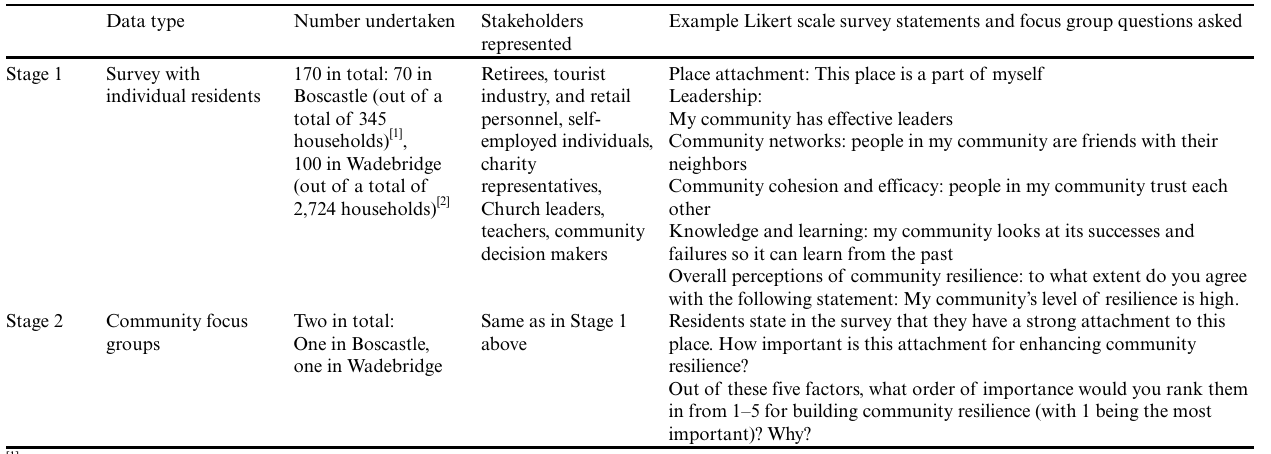
Table 3. Data collection in Boscastle and